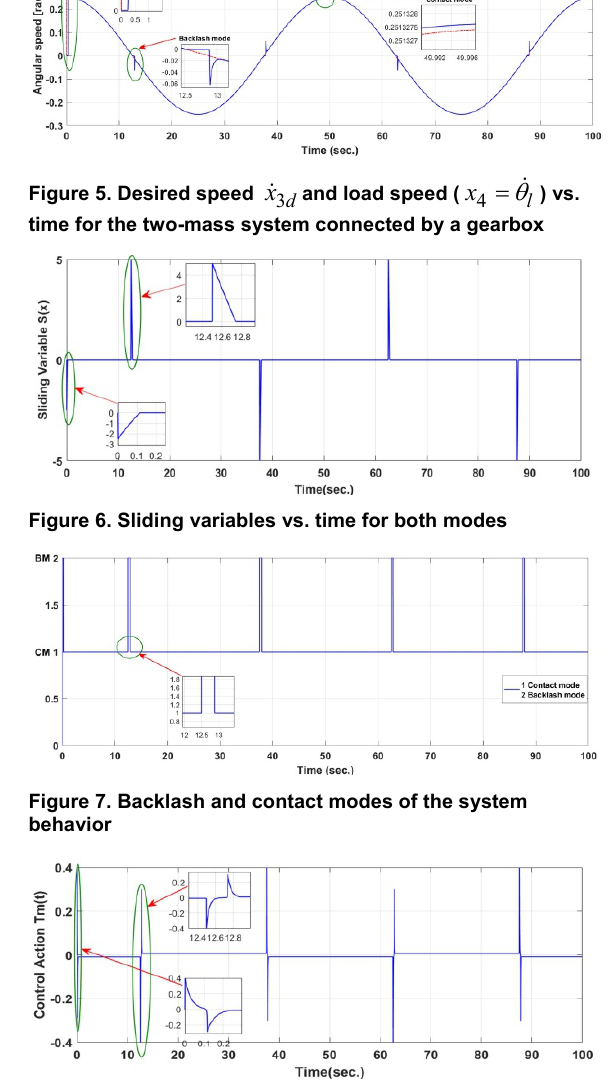
Figure 8. Control action T m ( t ) vs. time for the two-mass systems connected by a